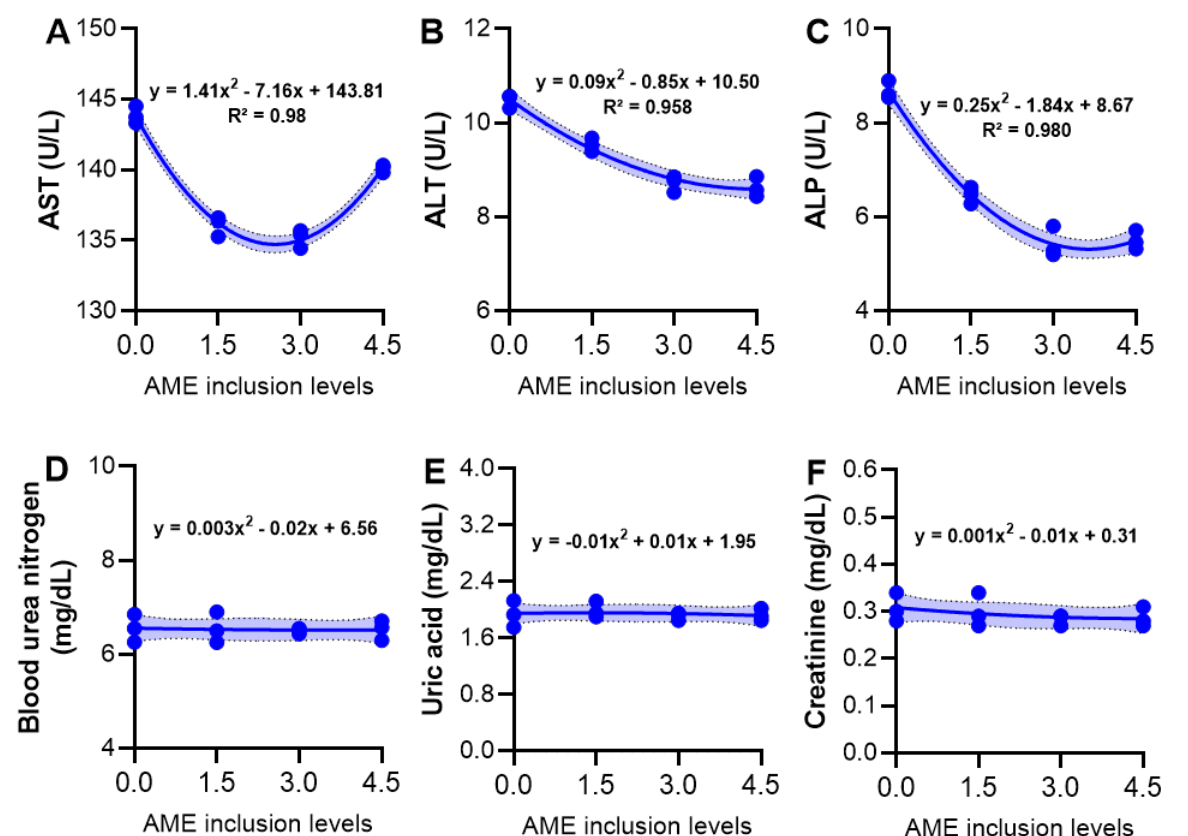
Figure 3. Serum biochemistry including AST ( A ), ALT ( B ), ALP ( C ), blood urea nitrogen ( D ), uric acid ( E ), and creatinine ( F ) of juvenile P. hypophthalmus fed diets with different AME inclusion levels over the feeding trial period of 56 days. Data lines denote best fit models for the data. Equations and R square in the figures demonstrate the relationship between the measured parameters and AME inclusion levels. Individual marker indicates the number of technical replicates (n = 3). Individual marker is the mean of two biological replicates.